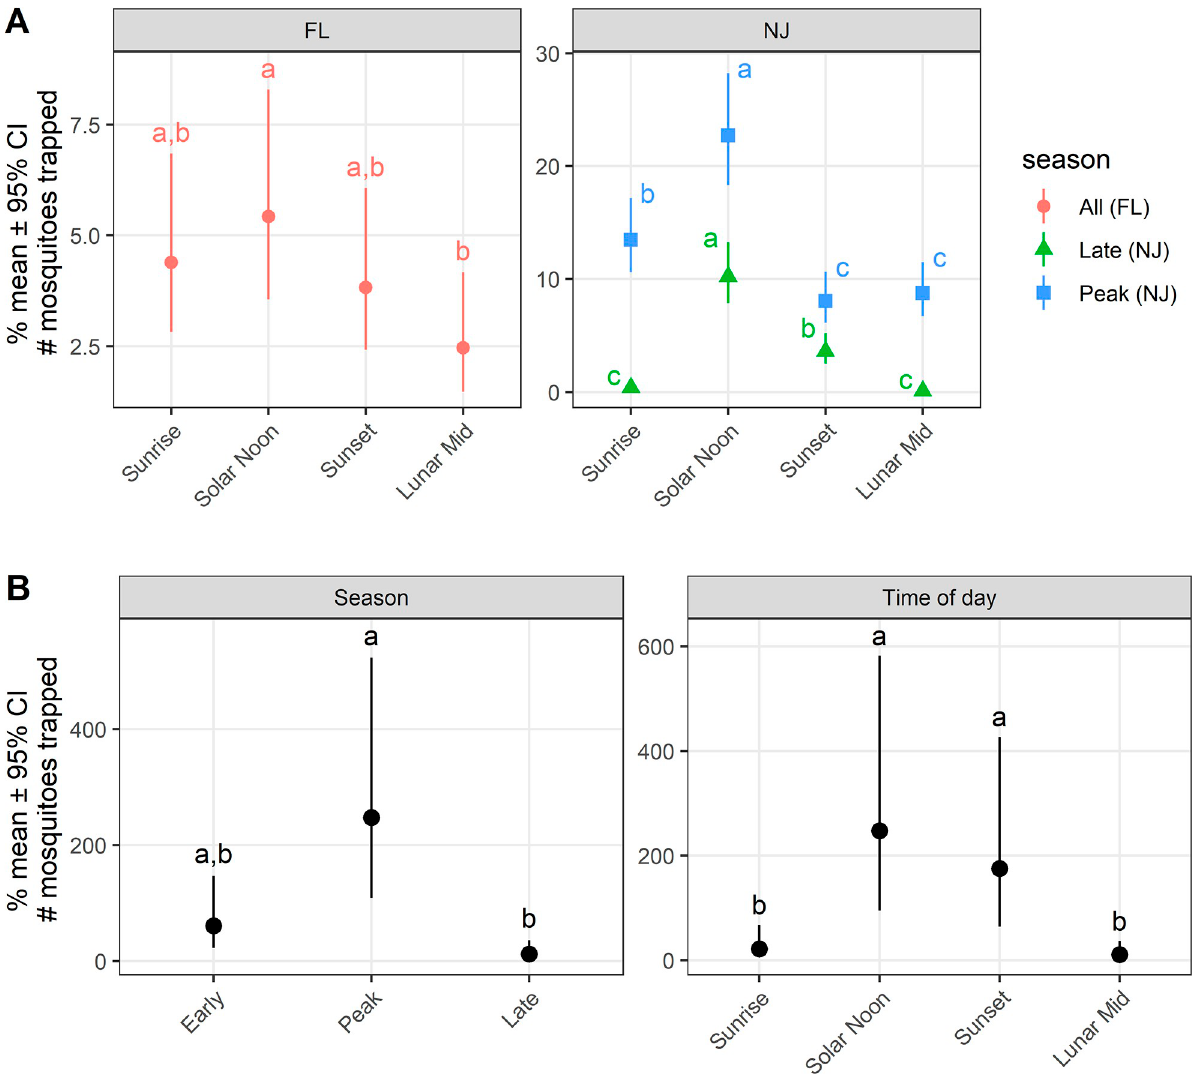
Fig 2. A. Human sweep netting counts from Florida for all Aedes albopictus during four time periods; Sunrise, Solar Noon, Sunset, and Lunar Midnight (red bars), and human sweep netting counts from New Jersey for all Aedes albopictus over two seasons (peak and late) and four time periods: Sunrise, Solar Noon, Sunset, and Lunar Midnight. B. Count bottle rotator trap counts of all Aedes albopictus at two study sites over three seasons (early, peak, and late) and over a 24 hr period in New Jersey. ¥ Values not sharing the same superscript are significantly different (Holm’s test, P <